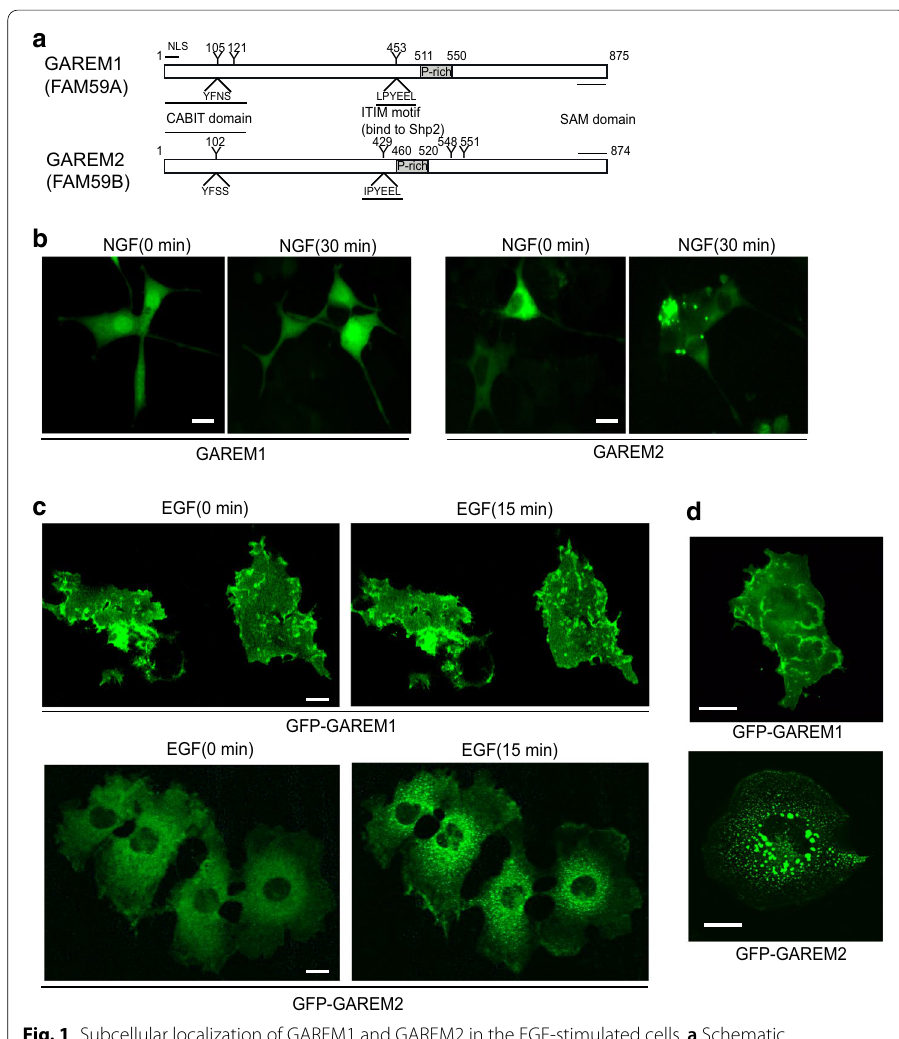
Fig. 1 Subcellular localization of GAREM1 and GAREM2 in the EGF-stimulated cells. a Schematic representations of GAREM1 (upper) and GAREM2 (lower) primary structure. Tyrosine residues (Y) of phosphorylation and the surrounding amino acid sequence in GAREM1 are indicated by numbers. Proline-rich regions (P-rich) that may bind the SH3 domain are indicated in the box. The amino acid sequence surrounding the phosphorylation site, Y453, is LP phospho YEEL; this site is a good match to the consensus sequence of the Shp binding site (ITIM). In addition, CABIT and SAM domains are indicated by underlined text. b Different subcellular localization between GAREM1 and GAREM2 in the NGF-stimulated PC-12 cells. Representative images of each endogenous GAREM1 (left) and GAREM2 (right) in PC-12 cells with (NGF 30 min) or without (NGF 0 min) NGF stimulation. Immunofluorescence staining was performed with specific antibodies against each GAREM subtype. c Different subcellular localization between GAREM1 and GAREM2 in the EGF-stimulated COS-7 cells. Representative images of each GFP-GAREM in COS-7 cells with (EGF 15 min) or without (EGF 0 min) EGF stimulation. Time-lapse images for tracing GFP-GAREM1 (upper), GFP-GAREM2 (lower). COS-7 cells were transfected with each GFP-GAREM after EGF treatment. The images were taken for 15 min at regular intervals of 30 s (Additional file 1: GAREM1, Additional file 2: GAREM2). Scale bars 10 μm. d Representative images of GFP-GAREM1 (left) and GFP-GAREM2 (right) in COS-7 cells treated = with EGF for 45